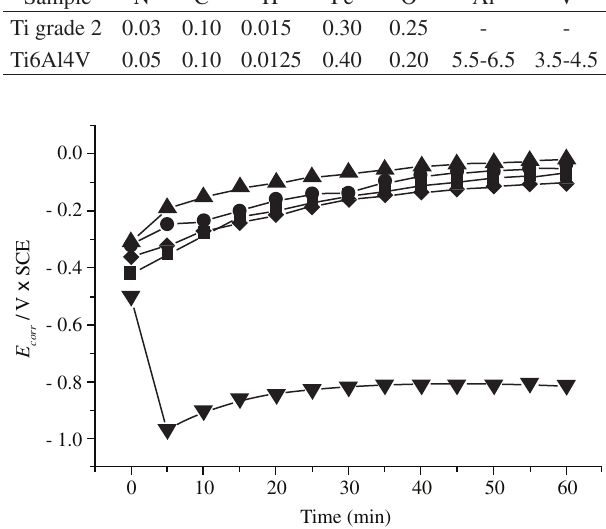
Figure 1. E variation of Ti6Al4V alloy as a function of immersion time corr in citric acid ( ■ ), containing bromide ( ● ), chloride ( ▲ ), fluoride ( ▼ ) and iodide ( ◆ ) ions.